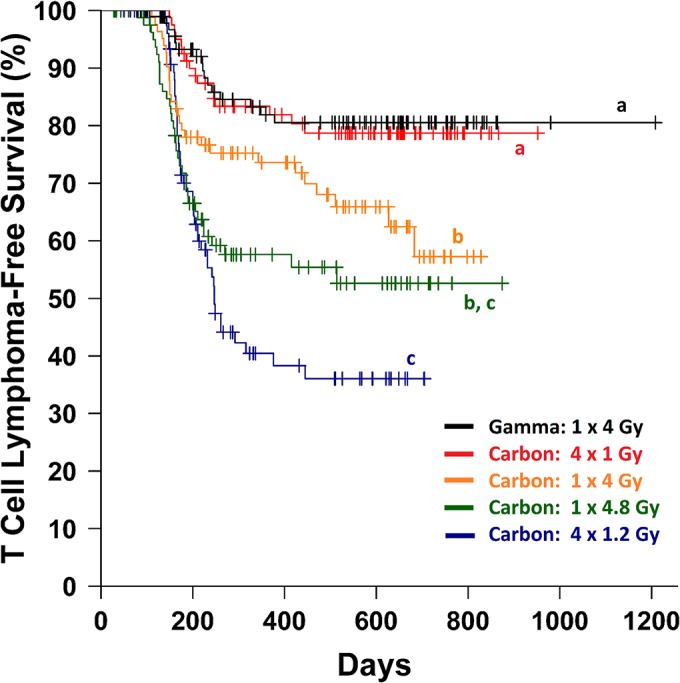
T Cell Lymphoma-Free Survival of Mice Irradiated with Gamma Rays or Carbon Ions.The Kaplan-Meier estimator is plotted for the five irradiation groups with censored cases (causes of death other than TL) marked with crosses. Curves sharing the same letter designation (a, b or c) are not significantly different by pairwise log-rank tests (P > 0.05).